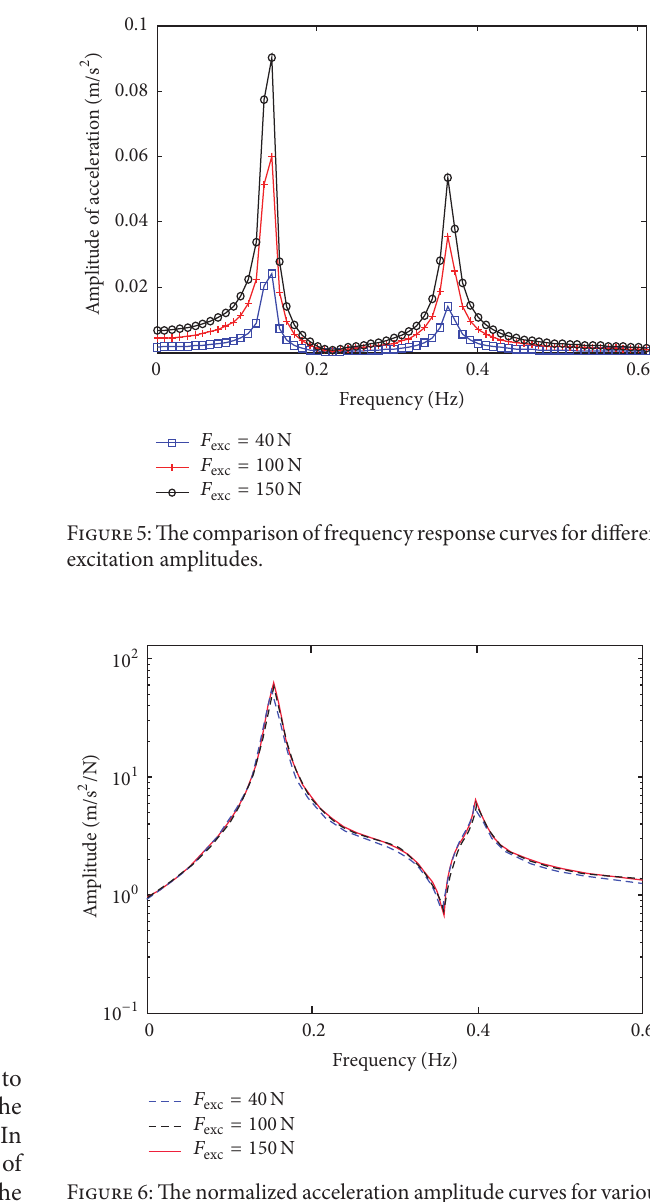
Figure 6: The normalized acceleration amplitude curves for various excitation amplitudes at torque = 8 N ⋅